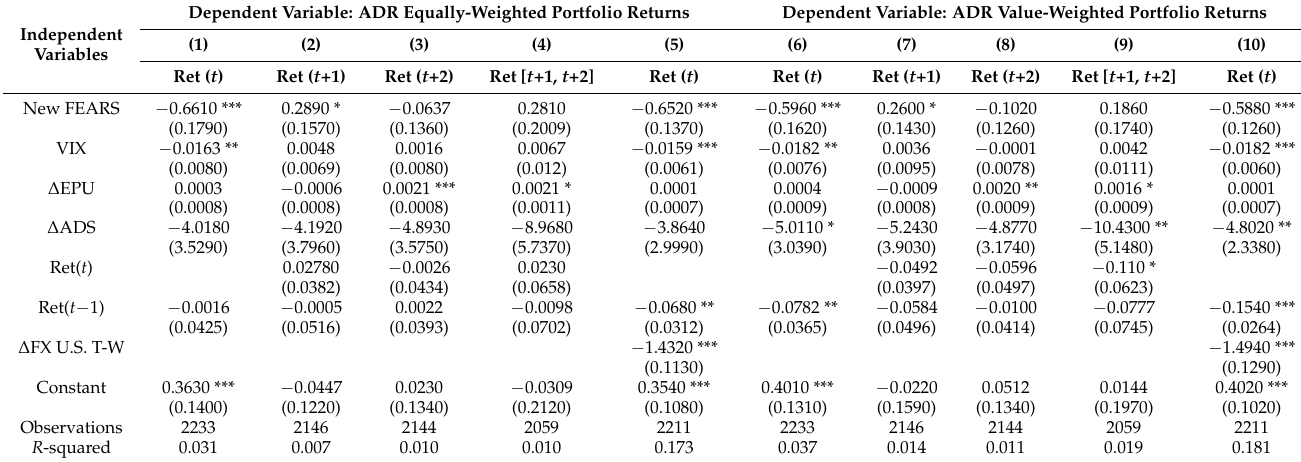
Table 4. New FEARS and equally-weighted and value-weighted ADR portfolio